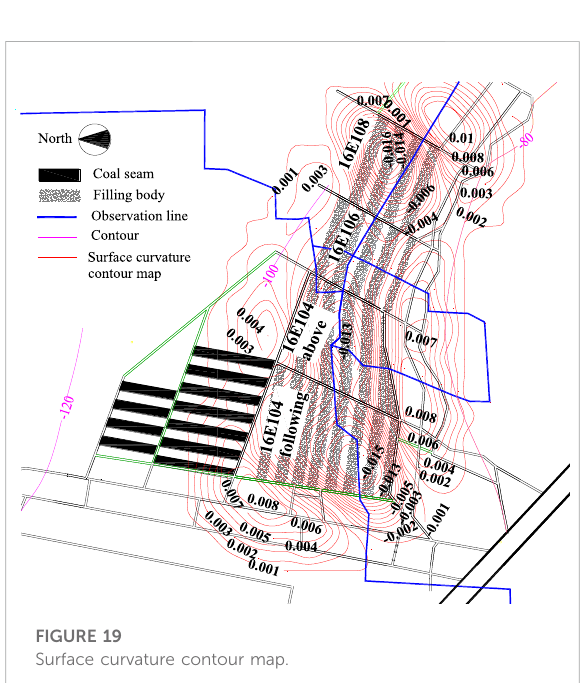
FIGURE 18 Surface tilt contour map.